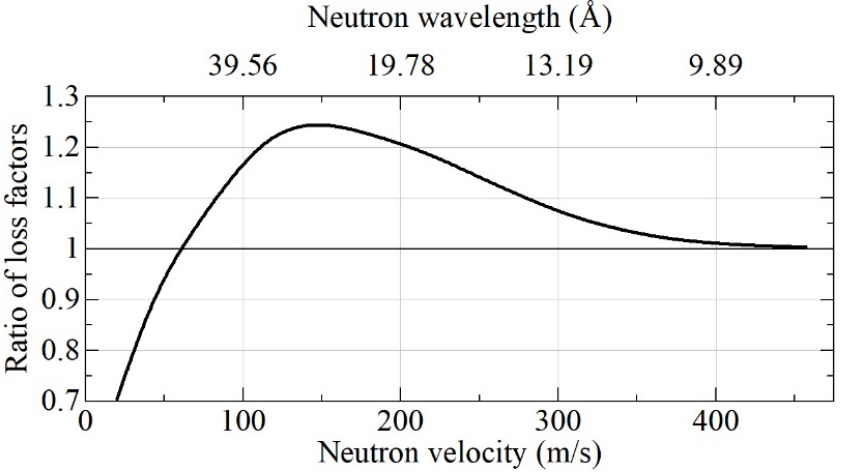
Figure 10. Ratio of loss factors η DF − DNDs / η S − DNDs at reflection from the wall of a spherical cavity with a radius of 5 cm and a wall thickness of 3 cm for realistic powder densities of 0.56 g/cm 3 for DF-DNDs and 0.67 g/cm 3 for S-DNDs.